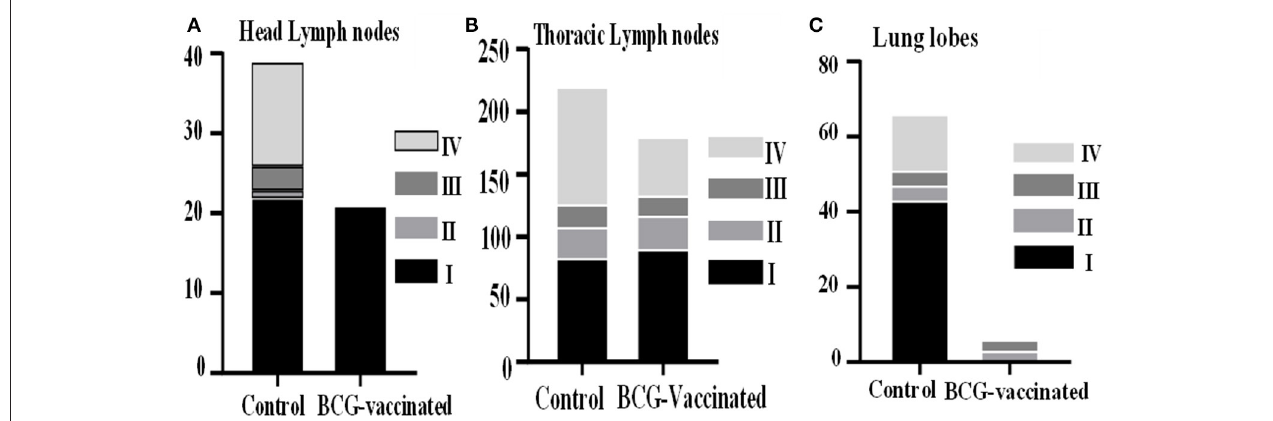
FIGURE 8 | Microscopic lesion scores of the experimental calves. The Figure shows the frequency of occurrence of the different granuloma stages (I–IV) within the head lymph nodes (A) , the thoracic lymph nodes (B) , and lung lobes (C) of control and vaccinated calves. The bars represent the percentage of granulomas with different stages.